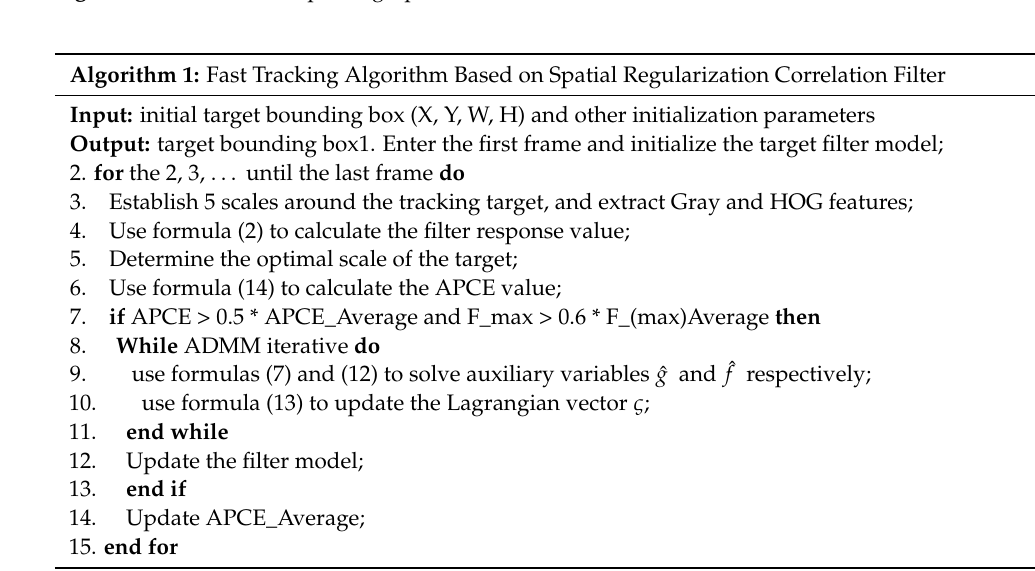
Figure 3. Peak tracker response graph.